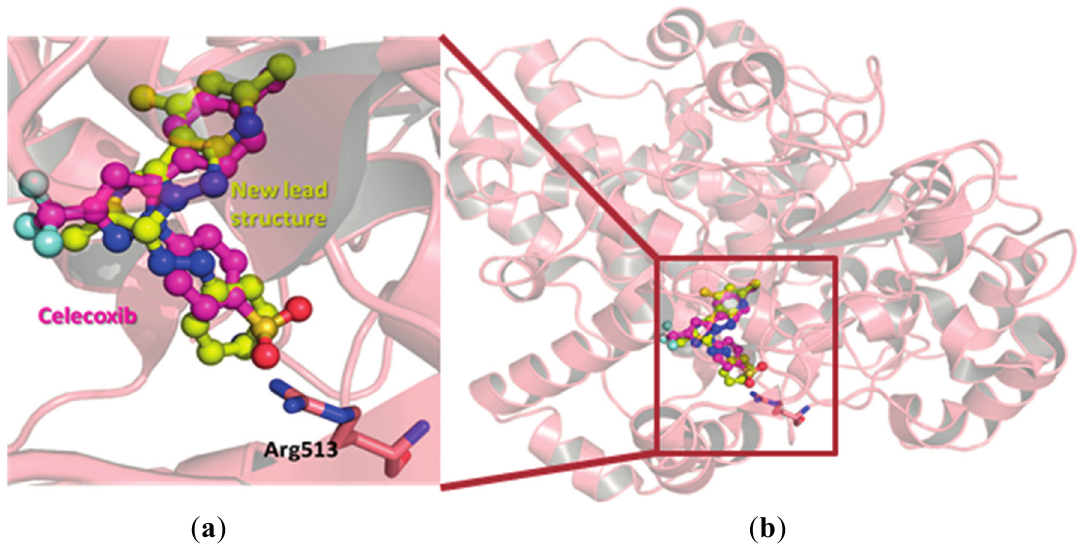
Figure 1. The hypothetical binding mode of the lead compound 5a (colored yellow) within COX-2 active site (PDB ID:3ln1), co-crystalized with celecoxib (colored magenta). The important Arg 513 residue was highlighted as sticks in Figure